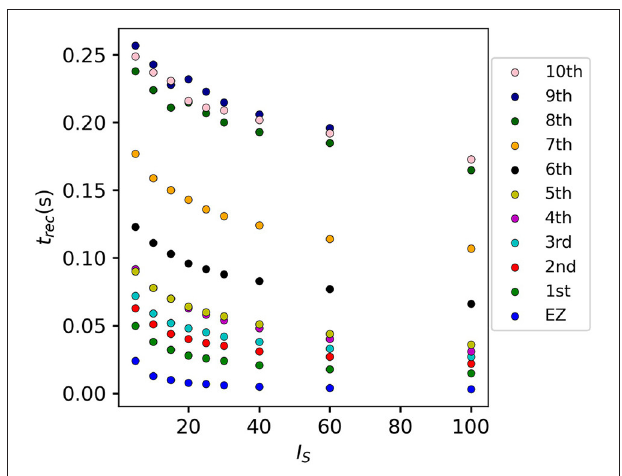
FIGURE 7 | Recruitment times of the first 10 recruited areas as a function of the input current I S . The strength of the input current is varied between 0 and 100 on the x -axis. The order of the recruitment is color-coded for each current strength, and it changes slightly with different current strengths. Parameters: N pop η ( k ) η 90, 1 1, σ 1, t I 0.4 s, 6, stimulation site: brain area = = = = ¯ = ¯ = − k 45 of subject =